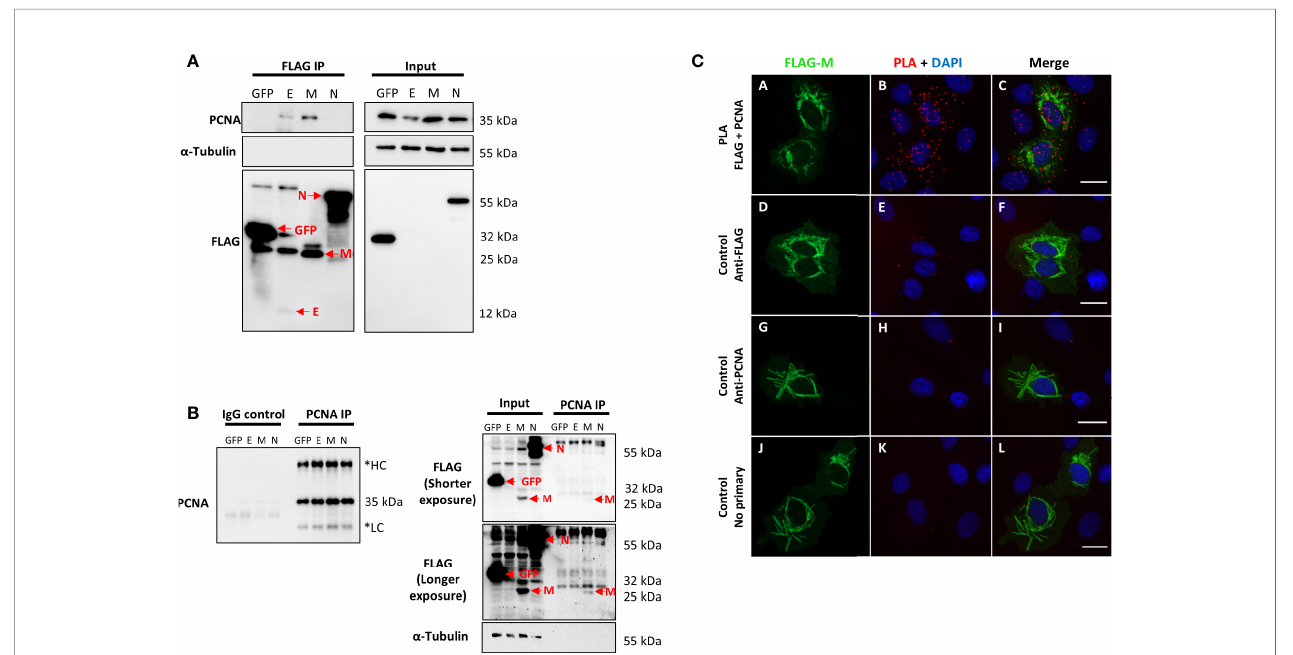
FIGURE 1 | SARS-CoV-2 structural proteins interact with PCNA in HEK293T and Vero E6 cells. FLAG-tagged GFP, E, M, and N proteins (indicated at the top of the panel) were expressed by transfection in HEK293T cells. Immunoprecipitation with anti-FLAG (A) or anti-PCNA antibodies (B) was performed (indicated on the panel ’ s top). Blots were done with the primary antibodies indicated on the panel ’ s left, and molecular weight markers sizes are indicated on the right. (A) PCNA was identi fi ed as an interactor of SARS-CoV-2 E and M proteins. (B) Immunoprecipitation of endogenous PCNA con fi rmed that protein M co-immunoprecipitated with PCNA. These data were obtained in one biological replicate. *HC, Heavy Chain; LC, Light chain. Red arrows indicate speci fi c bands. (C) Vero E6 cells were transfected with pFLAG ‐ M and submitted to ice-cold methanol fi xation after 24h, followed by incubation with the primary antibodies, as indicated on the left, and PLA staining protocol. Panels (A – C) show positive PLA dots for FLAG and PCNA staining in transfected cells. Little to no signal is detected in the respective controls omitting one or both primary antibodies [panels (D – L) ]. Images are representative of two independent experiments. Nuclei were stained with DAPI. All images were taken at 63× magni fi cation with a ZEISS Axio Vert.A1